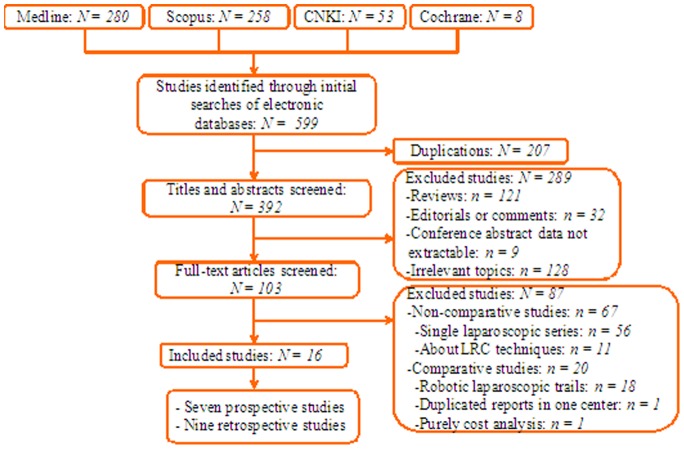
Flow chart of studies identified, included, and excluded.